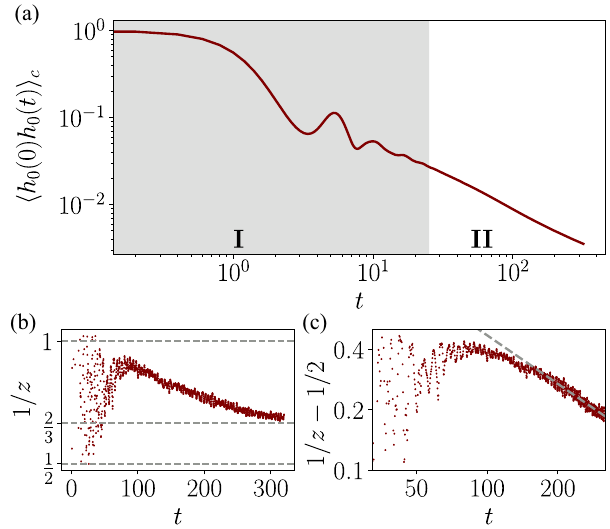
FIG. 1. (a) Connected energy autocorrelation function in the PXP model has a short-time oscillatory regime (I) followed by power-law decay (II). (b) The inverse of the instantaneous dynamical exponent extracted from the correlation function approaches the ballistic value of one at t ∼ 100 , followed by slow decay at later times. The decay appears to saturate to a superdiffusive value 1 =z ≈ 2 = 3 . (c) Double-logarithmic plot of the data in (b) shows that power-law convergence to diffusion 1 =z ¼ 1 = 2 is also consistent with the data. Dashed line corresponds to ∝ t − 0 . 8 dependence. The data are for a chain with N ¼ 1024 sites and bond dimension of χ ¼ 512 .